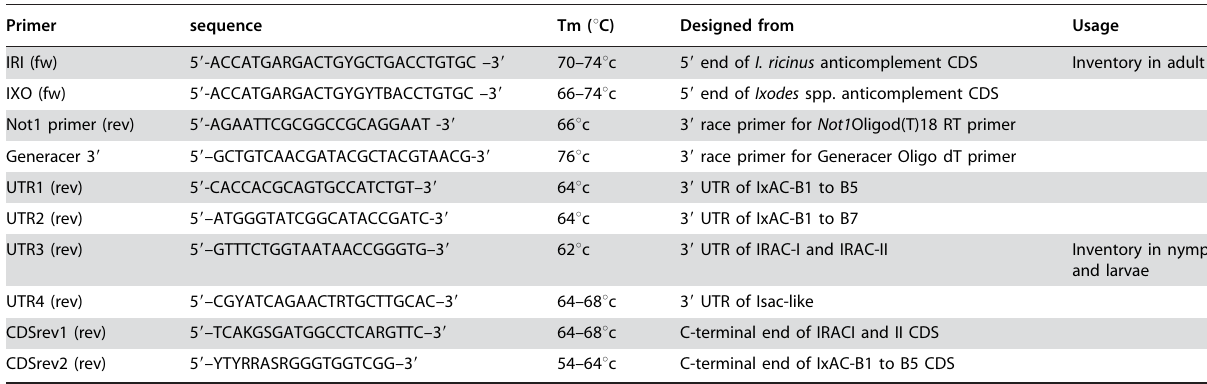
Table 1. PCR primers for RT-PCR inventory of I. ricinus genes coding for anticomplement proteins. .. ... .... ... ... .... ... ... .... ... ... .... ... ... .... ... ... .... ... ... .... ... ... .... ... ... .... ... ... .... ... ... .... ... ... .... ... ... .... ... ... .... ... ...